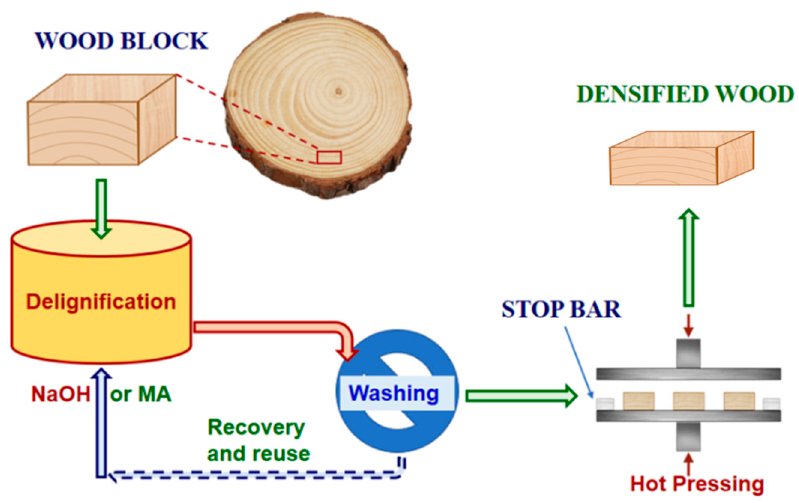
Figure 1. A schematic flow diagram showing wood block cutting, chemical delignification, and densification through hot-pressing.